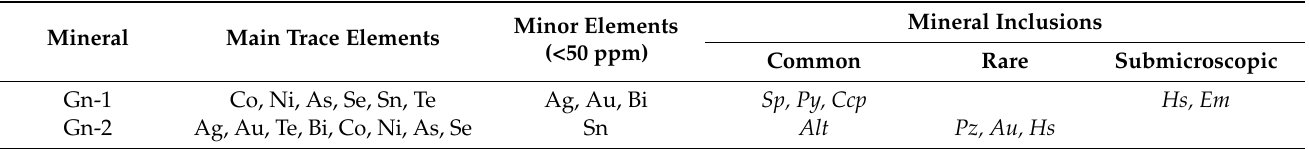
Table 13. Occurrence forms of main and trace elements and their mineral inclusions in galena of different assemblages of the Petropavlovsk gold-porphyry